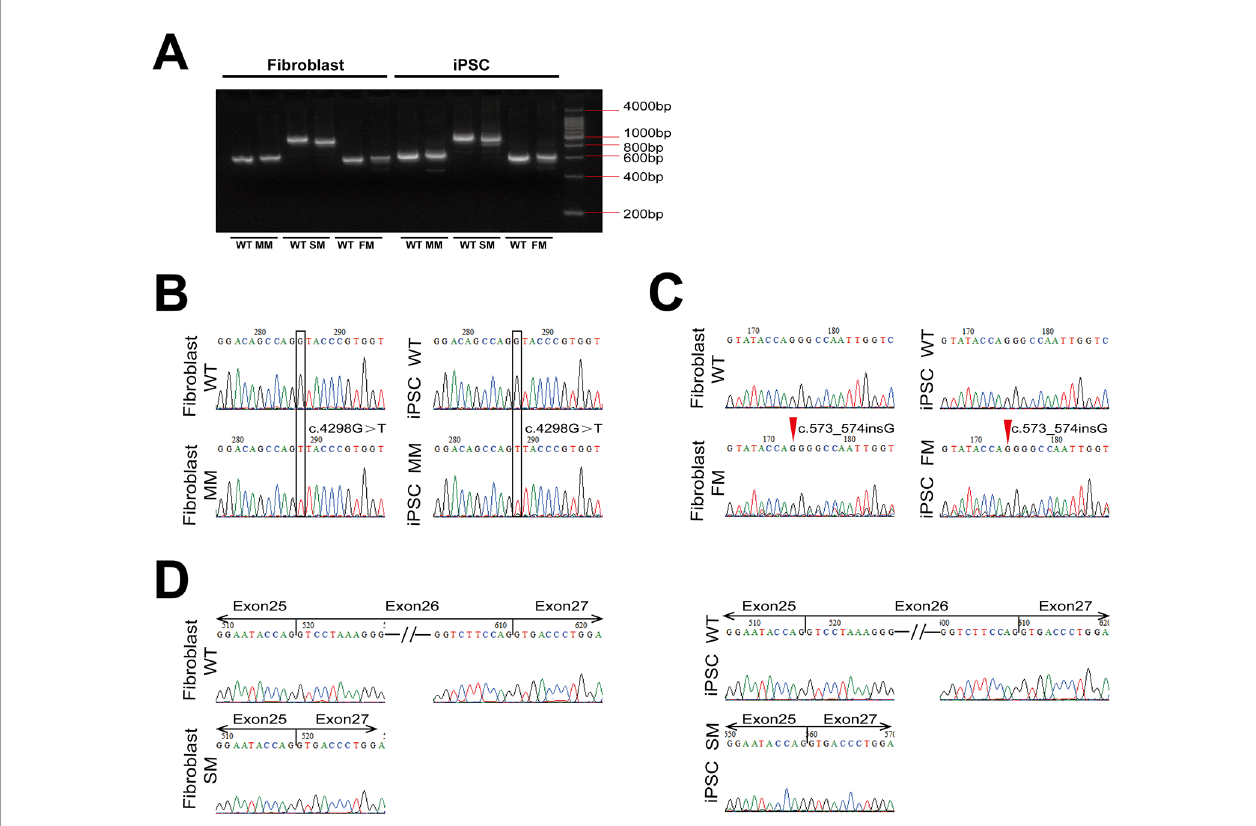
FIGURE 2 | The expression of COL4A5 variants in fi broblasts and iPSCs. (A) RT-PCR ampli fi cation was used with speci fi c primers containing the mutation site of COL4A5 . (B – D) COL4A5 sequence variants in the missense mutation (B) , frameshift mutation (C) , and splicing mutation (D) fi broblasts and iPSCs identi fi ed by Sanger sequencing. (MM, missense mutation; SM, splicing mutation; FM, frameshift